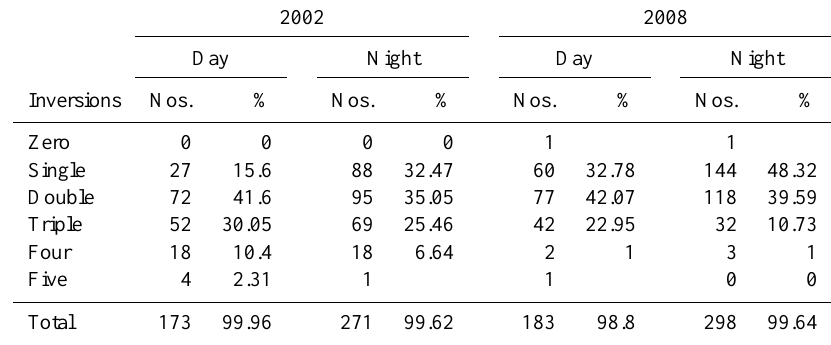
Table 1. Statistics of multiple mesospheric inversion layer (MIL) occurrences during the years 2002 and